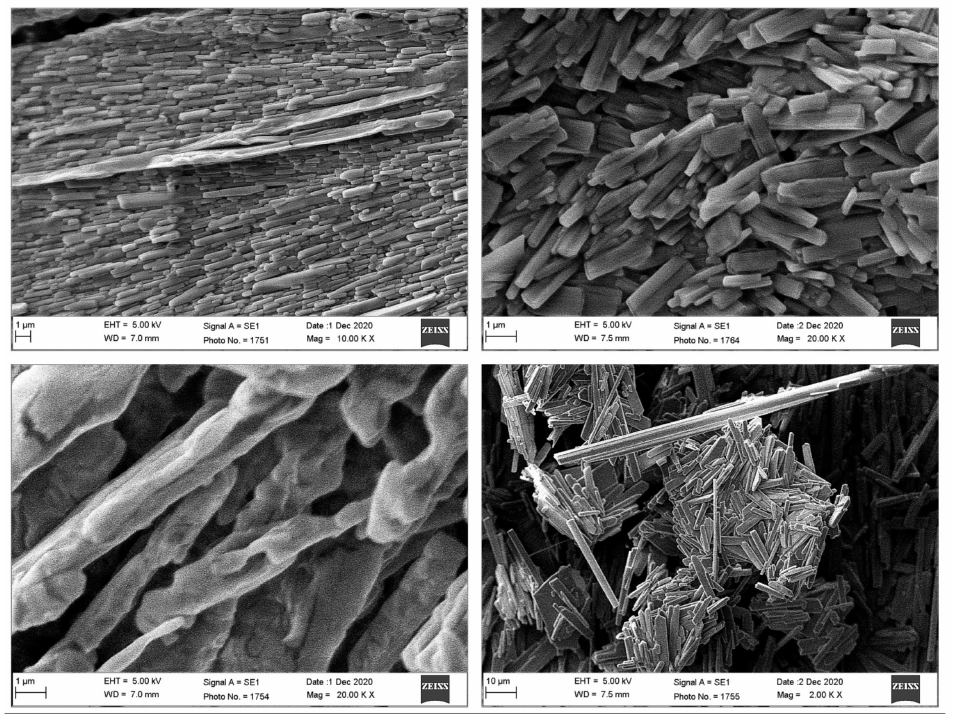
Figure 2. SEM images of the lyophilized NANIMAs including, STIN ( upper left ), S2TIN ( upper right ), TSIN ( lower left ), and T2SIN ( lower right